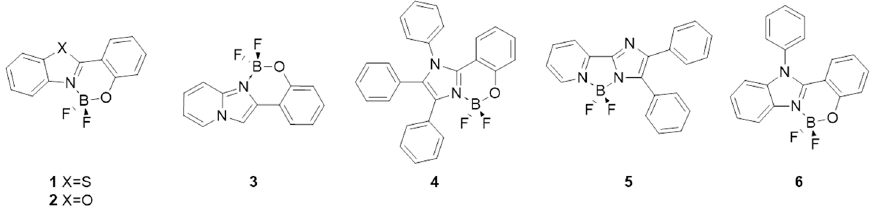
Figure 1. Azole-based organoboron compounds suitable for optoelectronic applications.